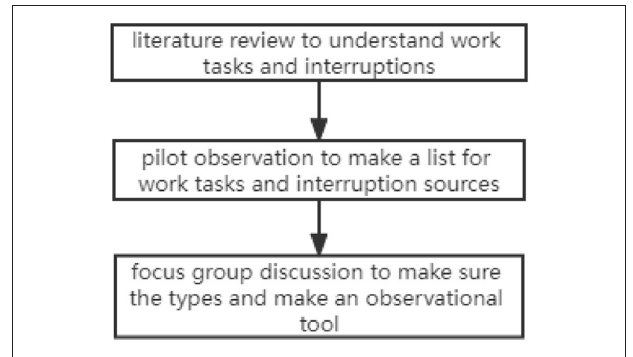
FIGURE 1 | Three phases to make the observational tool.